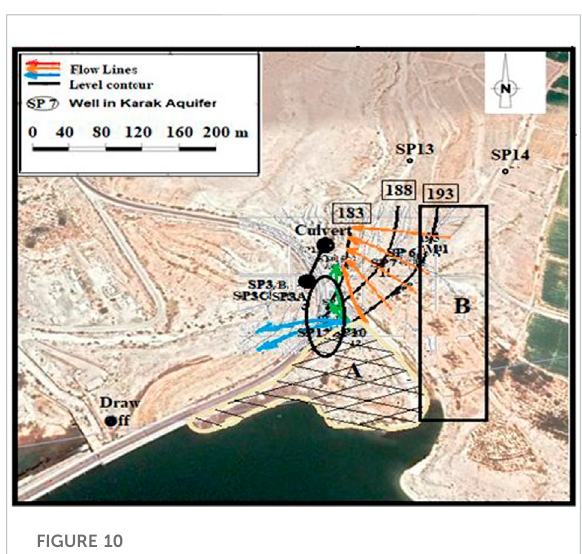
FIGURE 10 Probableseepagepathsfromareas (A),(B) colorsindicatethe different